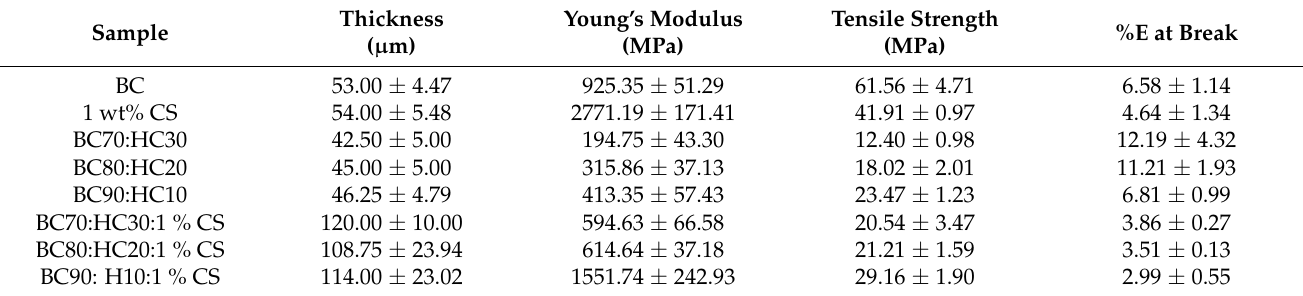
Table 1. Mechanical properties of BC film, CS film, BC:HC films, and CS-coated BC:HC films.